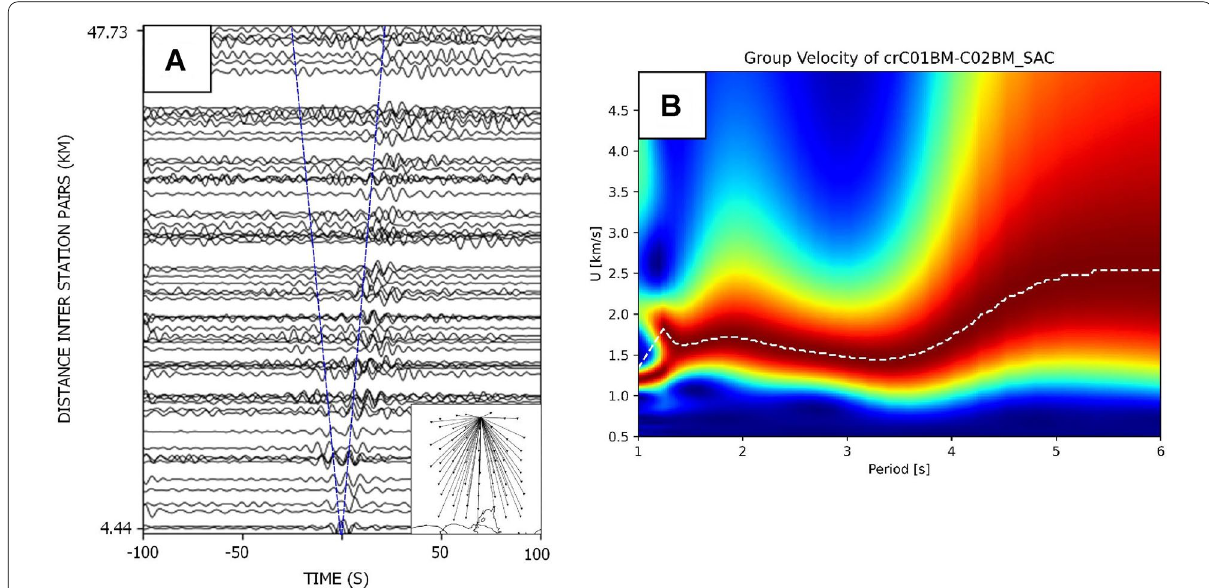
Fig. 2 A Cross-correlogram between station pairs C33 against all possible receiving stations with an average Rayleigh wave velocity of 2.12 km/s. The position between station C33 and the other stations is indicated on the inset map. The blue dashed line indicates the lag time trend of the Rayleigh EGF waves as the distance between stations increased. B The dispersion curve of the EGF picking process between stations C01–C02. The white dashed line indicates the result of group velocity picked at the top of the envelope, with the red area denoting the maximum energy possessed by the Rayleigh